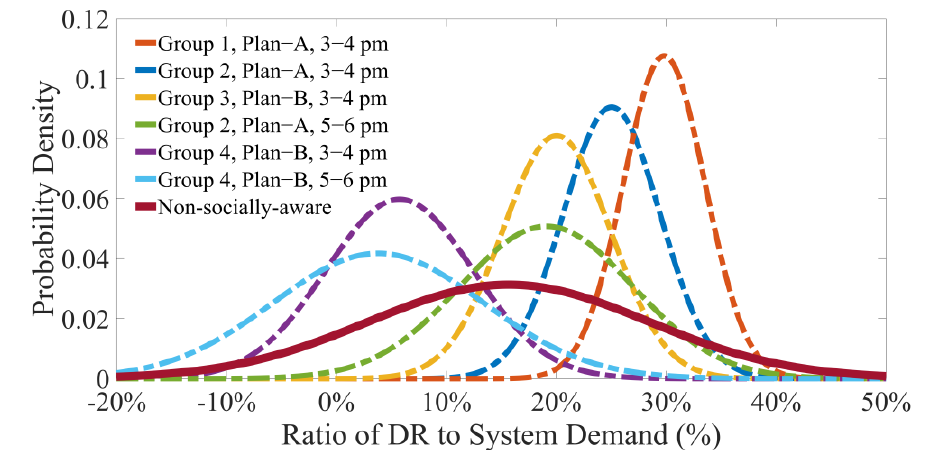
Figure 4. The effect of socially aware